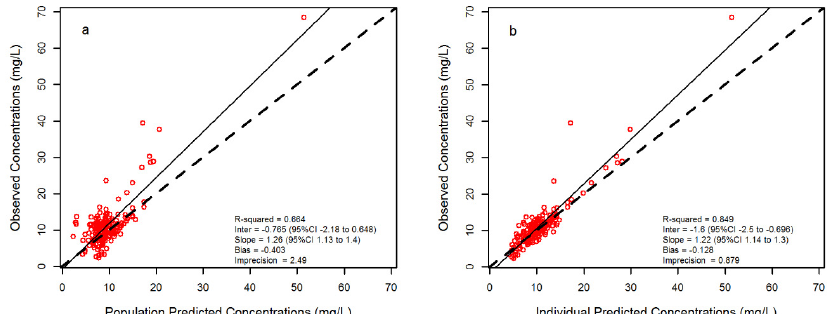
Figure 1. Scatter and linear fit plot for the final population pharmacokinetic model. Observed versus population-predicted plasma concentrations ( a ) and observed versus individual-predicted plasma concentrations ( b ). Solid lines are the lines of regression between observed and predicted concentrations. Dashed lines are the lines of identity. Red rings are meropenem concentrations.